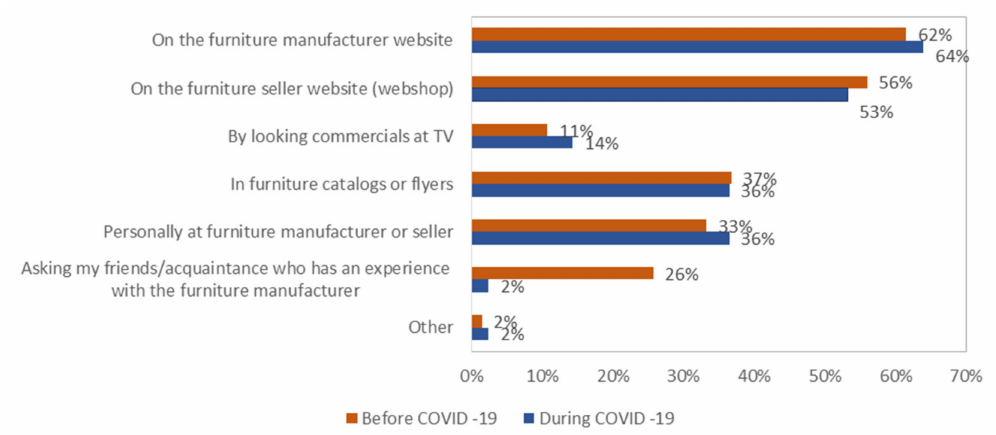
Figure 9. Comparison of the locations used to search for information about furniture before ( N = 400) and during the COVID-19 pandemic ( N = 244).